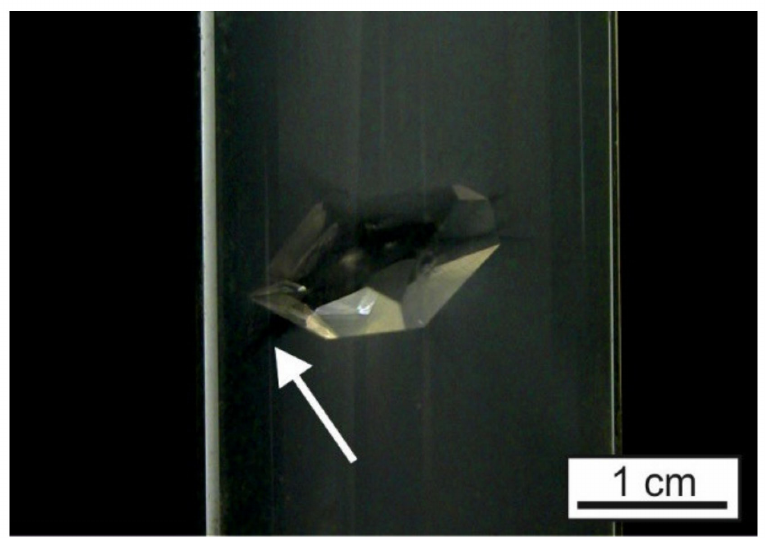
Figure 14. ‘Cusps’, cracks in gel which have been pushed away by the growing crystal, can some- times be seen macroscopically, such as in this example of sodium hydrogenoxalate dihydrate, NaH(OOC) 2 · 2H 2 O, grown in a HCl-acidified silica gel, acted upon by 1 m oxalic acid.